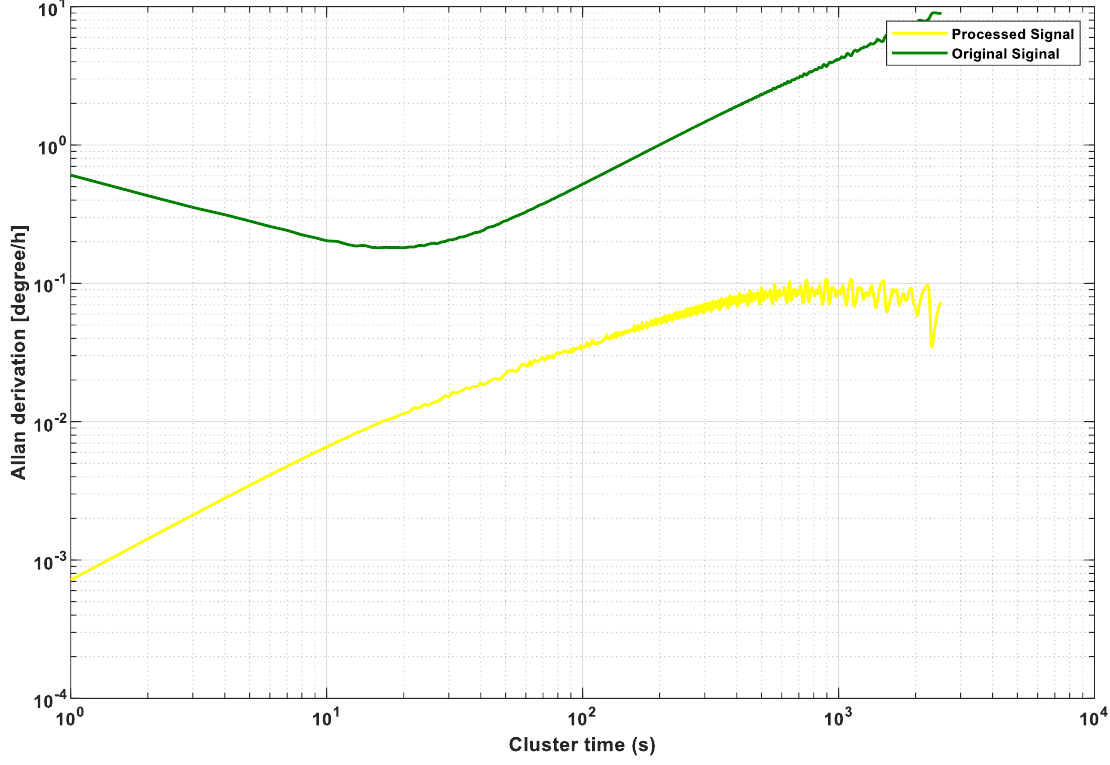
Figure 17. Allan variance curve comparison.